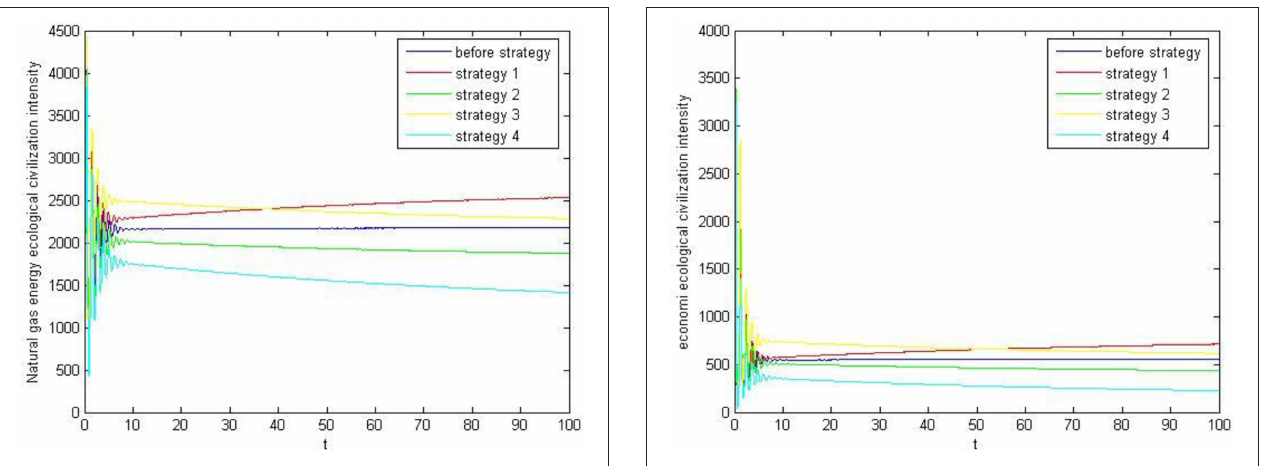
FIGURE 9 | Intensity of natural gas energy. FIGURE 10 | Intensity of economic ecological civilization.